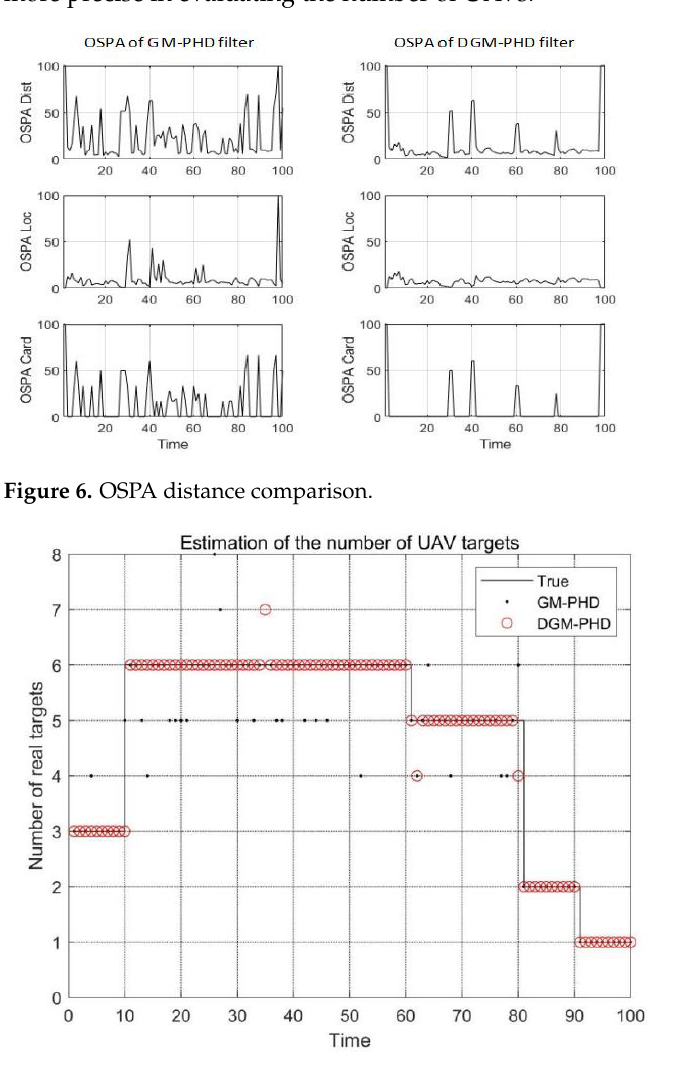
Figure 8. Average OSPA distance of the two filters with the increase of clutter density. The DGM-PHD filter can achieve the trajectory tracking of UAVs in conditions of high-density clutter by clustering the filtering results and using historical data to eliminate false alarms. As such, it is more effective than the traditional GM-PHD filter.